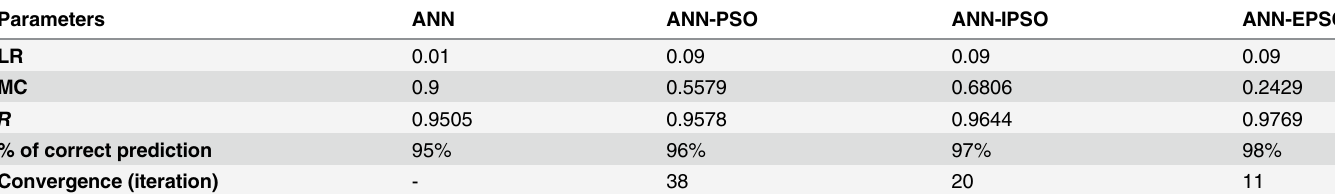
Table 8. Comparison of the results between different techniques.